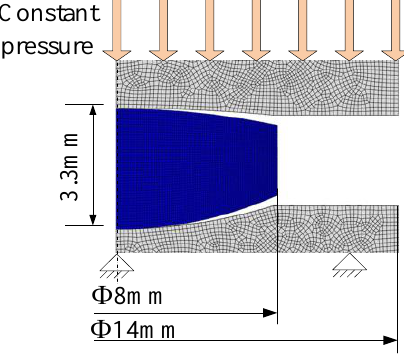
Figure 10. A half simulation model of ChG aspherical lens molding [49].